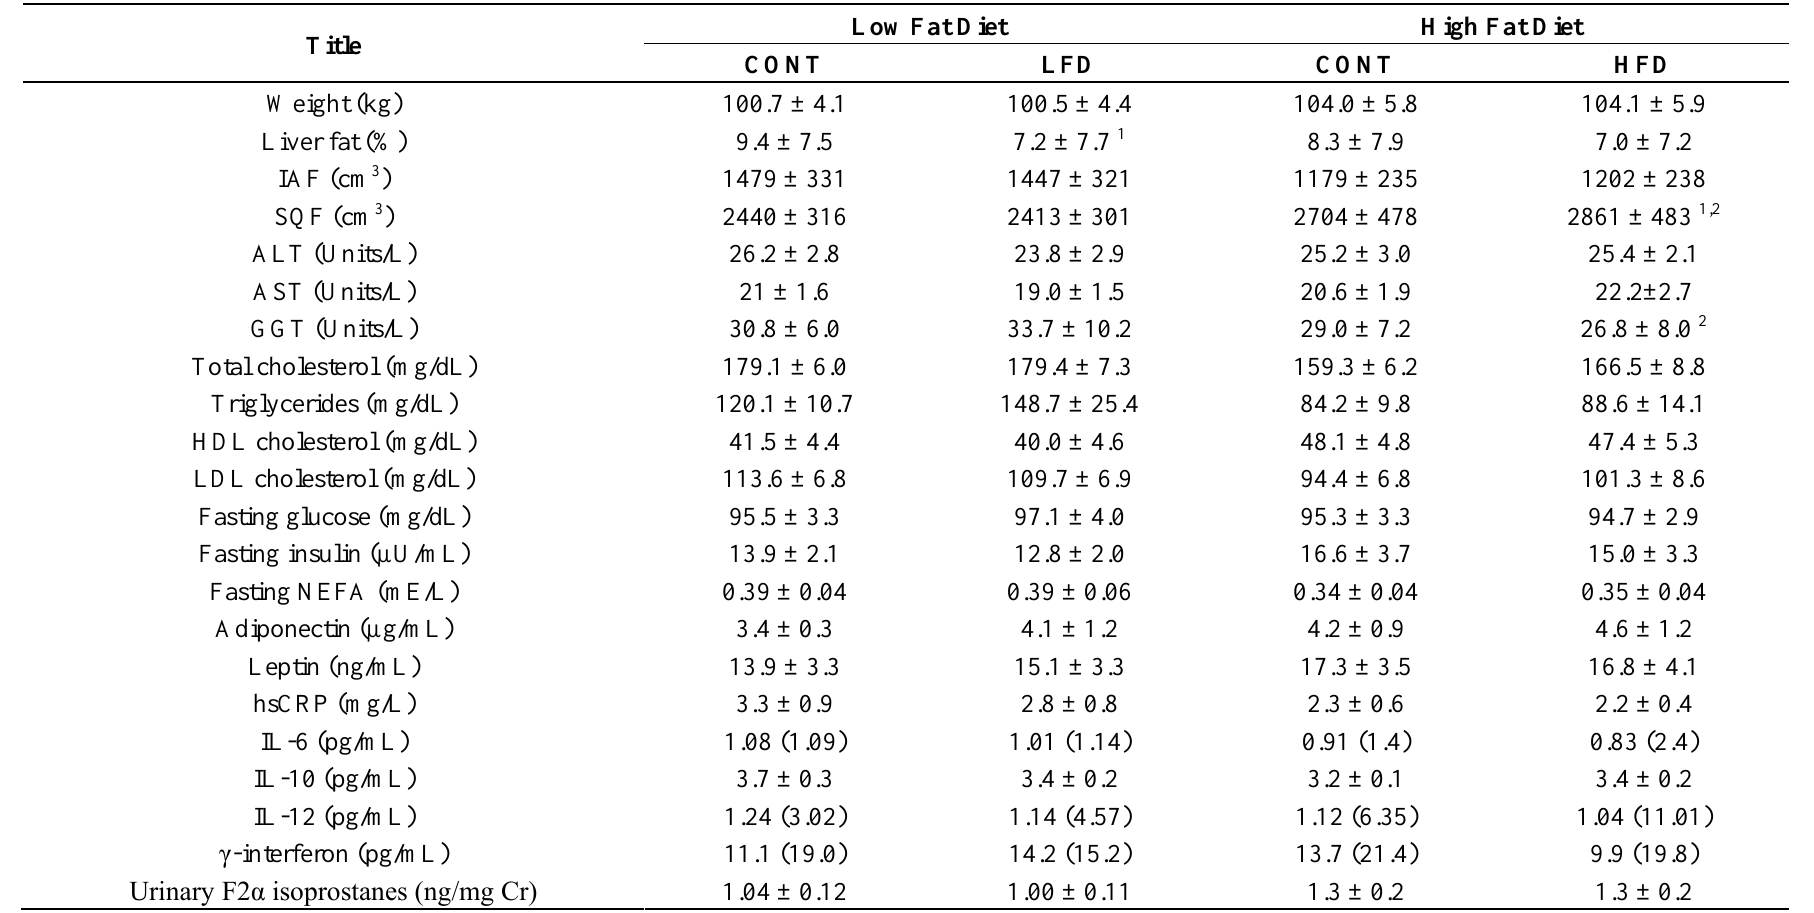
Table 2. Effect of the diets on body weight, liver fat, abdominal fat distribution and metabolic